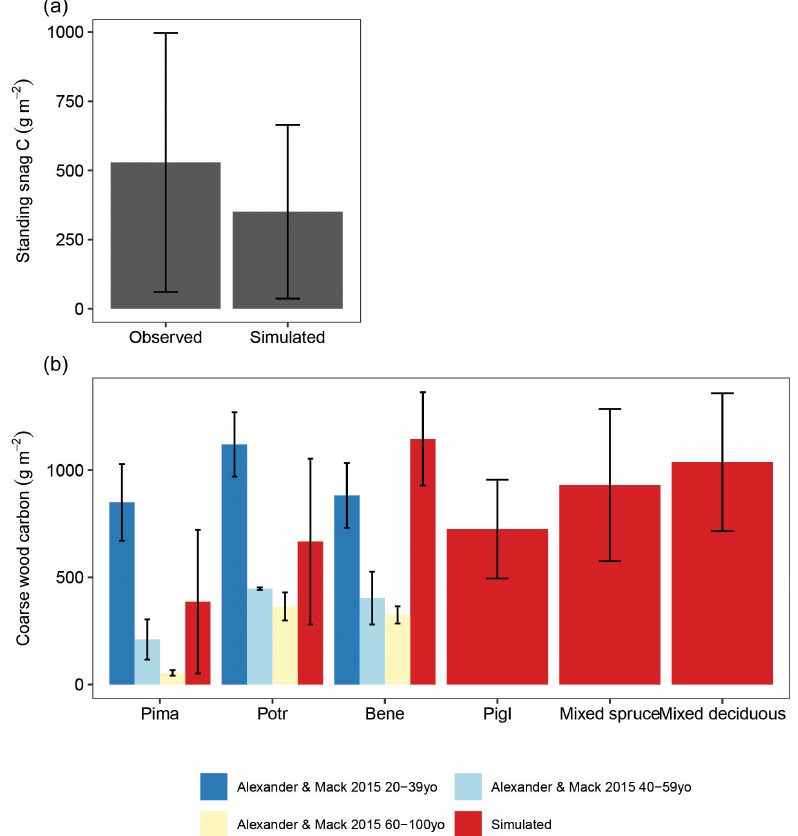
Figure B3. Observed and simulated (a) standing snag carbon and (b) downed coarse-wood carbon as a function of dominant forest type. Bars and whiskers show means ± 1 standard deviation in plot (a) and means ± 1 standard error due to the limited availability of the raw field observations. Modeled carbon stocks are from simulation year 300 in a 61000 ha forested landscape in interior Alaska. Observations are from field sampling in other boreal forest